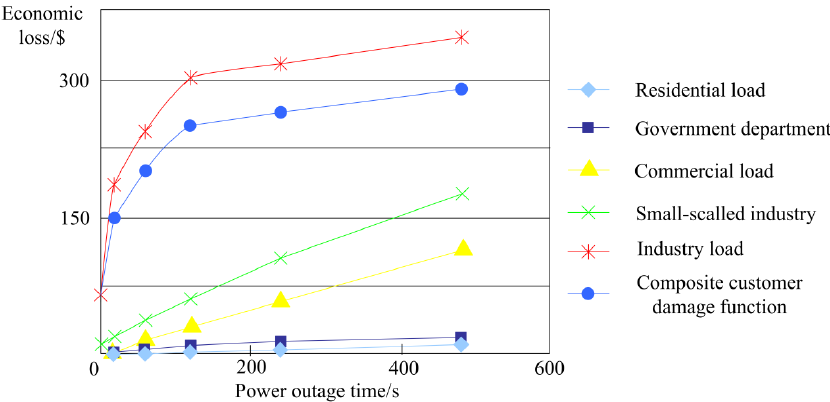
Figure 3. Economic loss curve of typical load after power